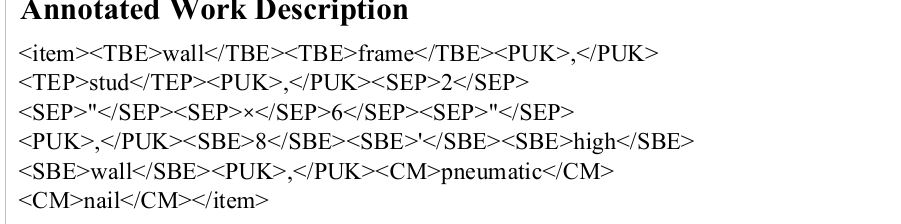
Figure 4. Example of annotated cost item.